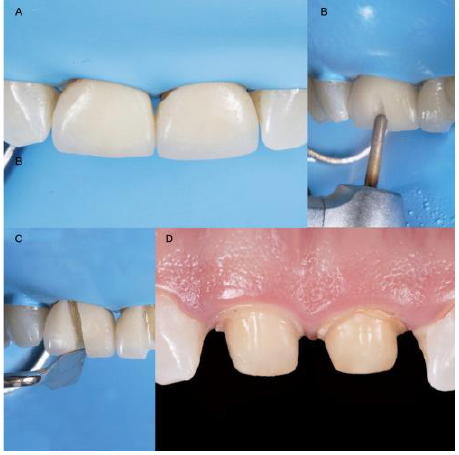
Figure 2. Crown prostheses removal: ( A ) Rubber dam isolation; ( B ) Initial channel in buccal surface; ( C ) Use of hand instrument for wedging; ( D ) Abutment assessment. The diagnostic overlay was placed over the teeth to guide the desired contour through gingivoplasty with an electrosurgical unit (Sensimatic 700SE Electrosurge, Parkell, Edge- wood, NY, USA) (Figures 3 and 4).